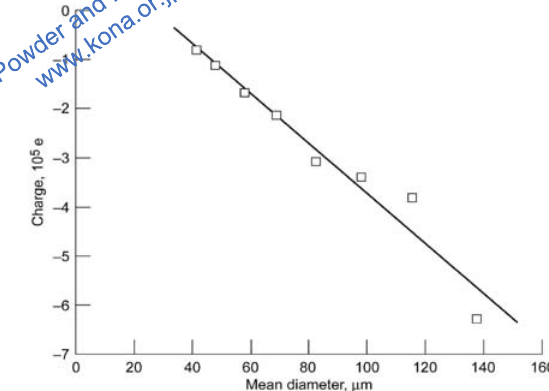
Fig. 4 The charge on JSC-Mars-1 from a contact with a Co surface for different dust sizes [Sternovsky et al ,